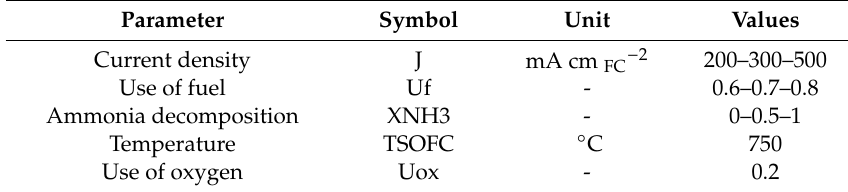
Table 3. Test condition investigated in the experimental